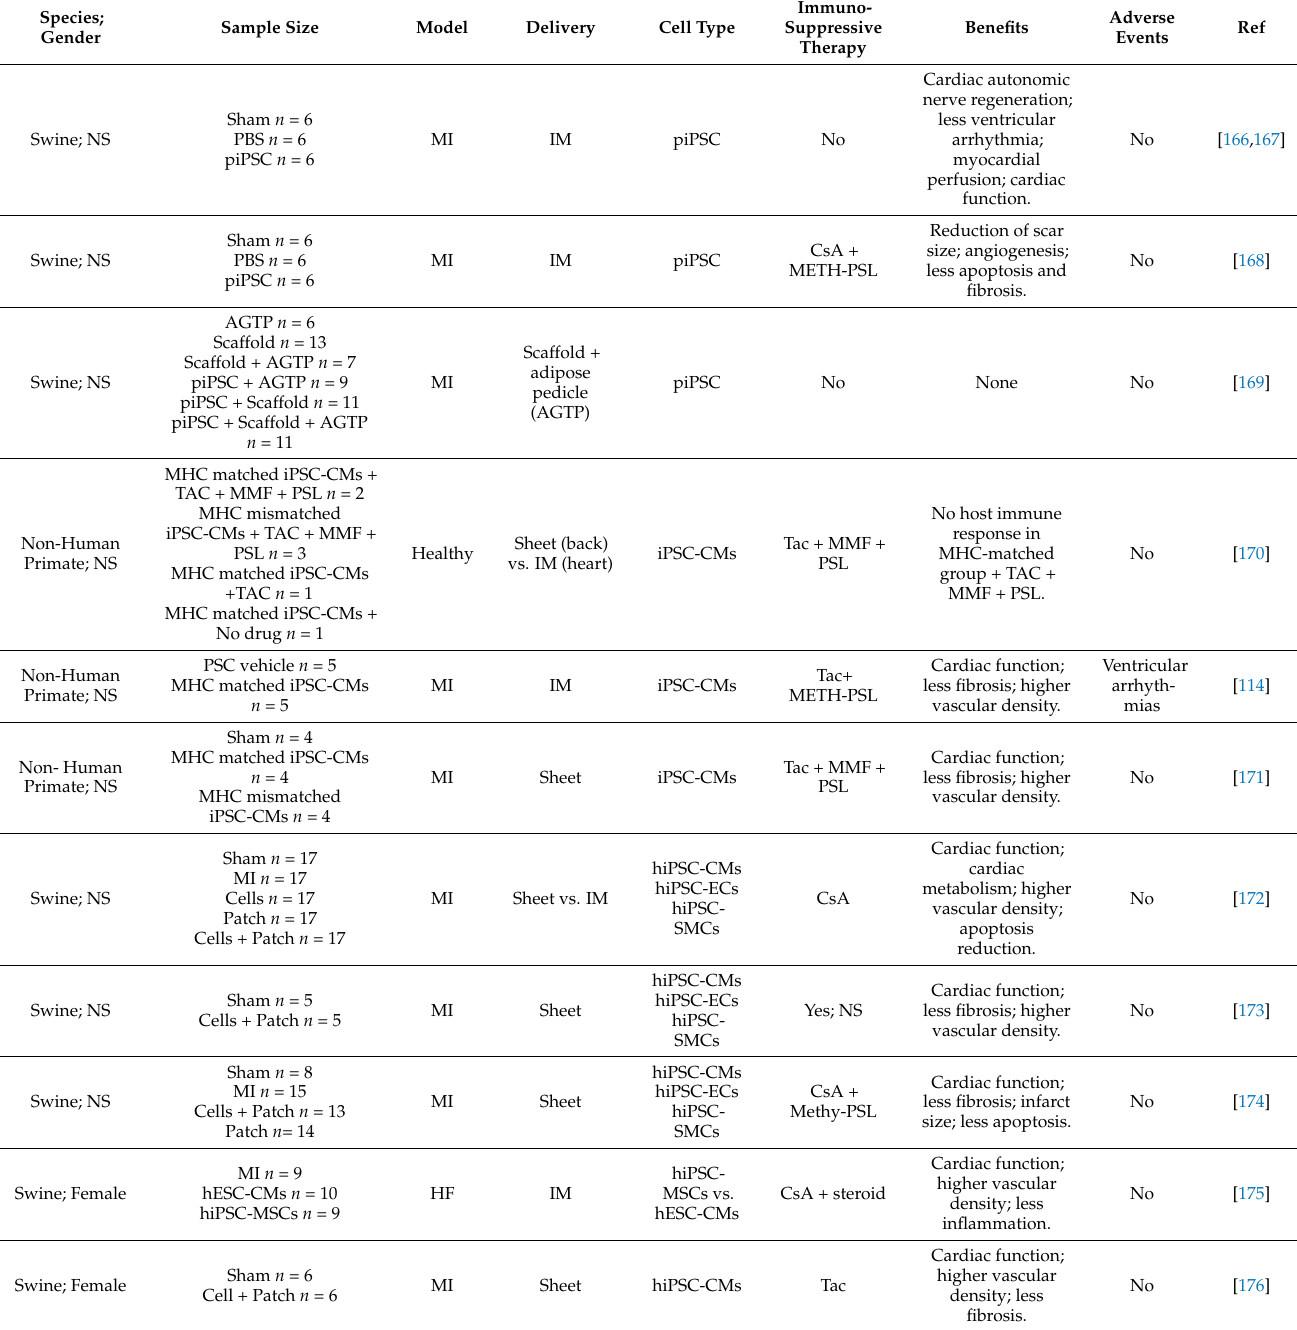
Table 2. iPSC studies in large animals. MI: myocardial infarction; HF: heart failure; hESC-CMs: human embryonic stem cell-derived cardiomyocytes; hiPSC-CMs: human induced pluripotent stem cell-derived cardiomyocytes; hiPSC-ECs: human induced pluripotent stem cell-derived endothelial cells; hiPSC-MSCs: human induced pluripotent stem cell-derived mesenchymal stem cells; hMSCs: human mesenchymal stem cells; hiPSC-SMCs: human induced pluripotent stem cell- derived smooth muscle cells; Tac: Tacrolimus; CsA: Cyclosporine; MMF: Mycophenolate mofetil; PSL: prednisolone; Methylene prednisolone: METH-PSL; NS: not